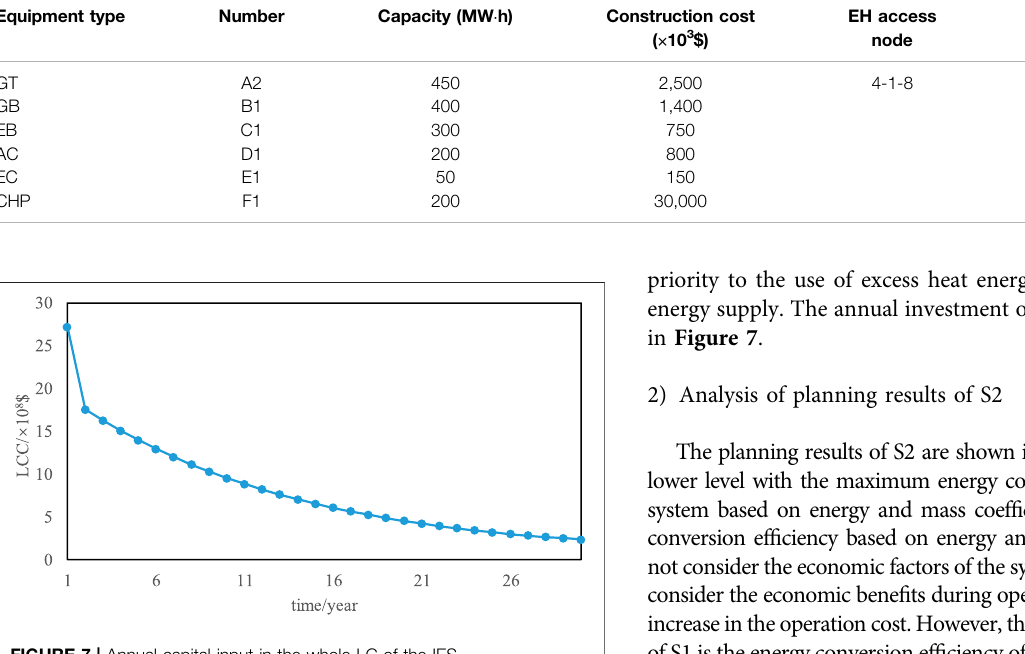
FIGURE 7 | Annual capital input in the whole LC of the